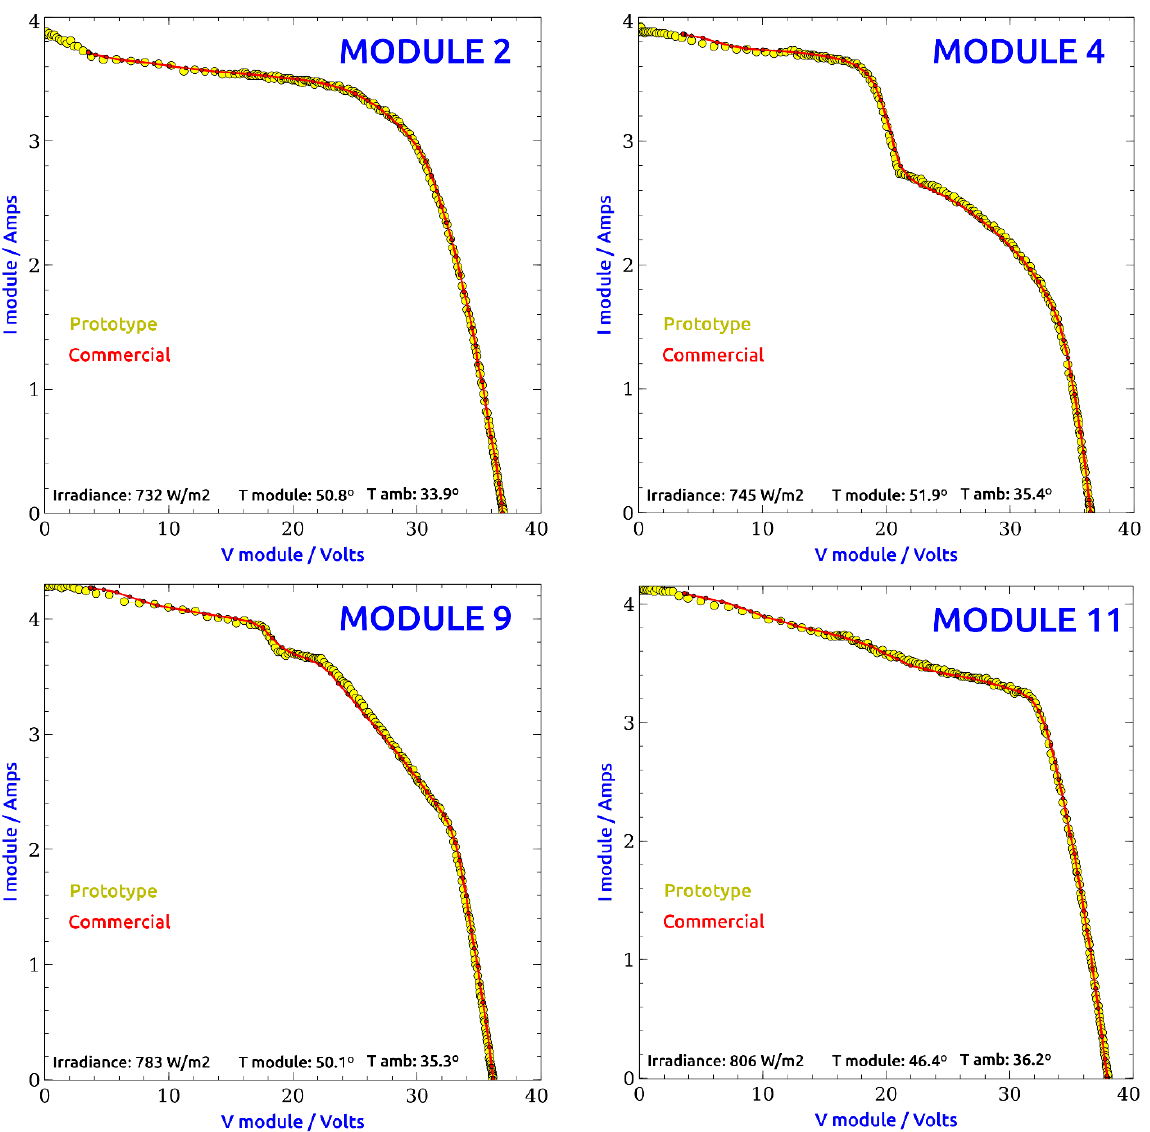
Figure 10. Distributed strategy/commercial tester comparison curves.